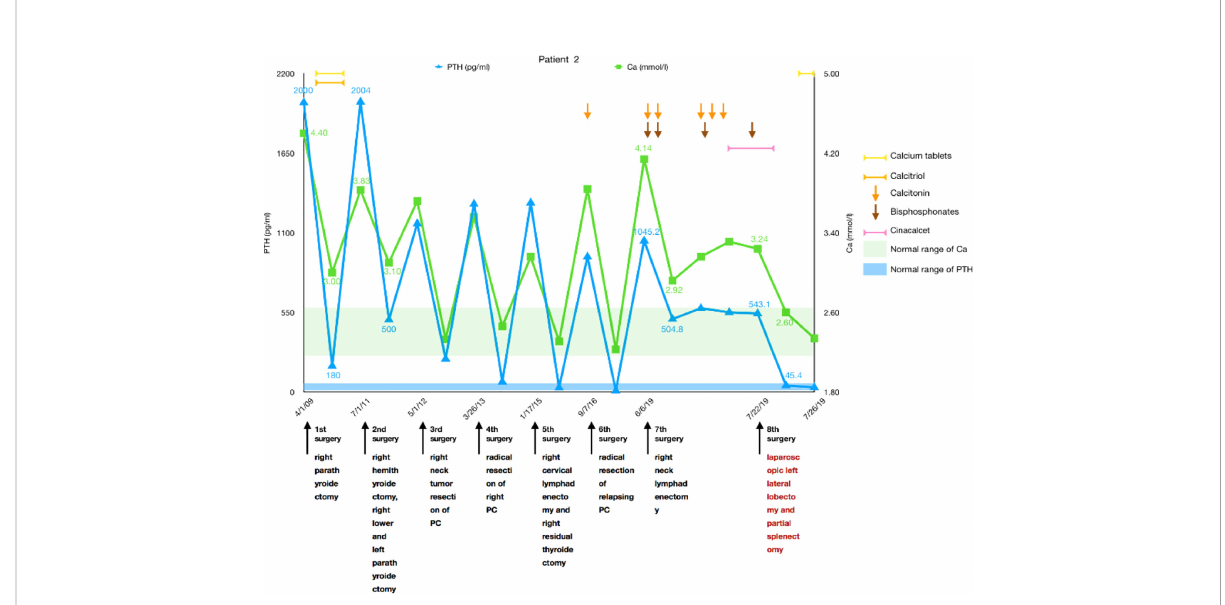
FIGURE 2 Summary of the clinical course, including changes in serum calcium and PTH of patient